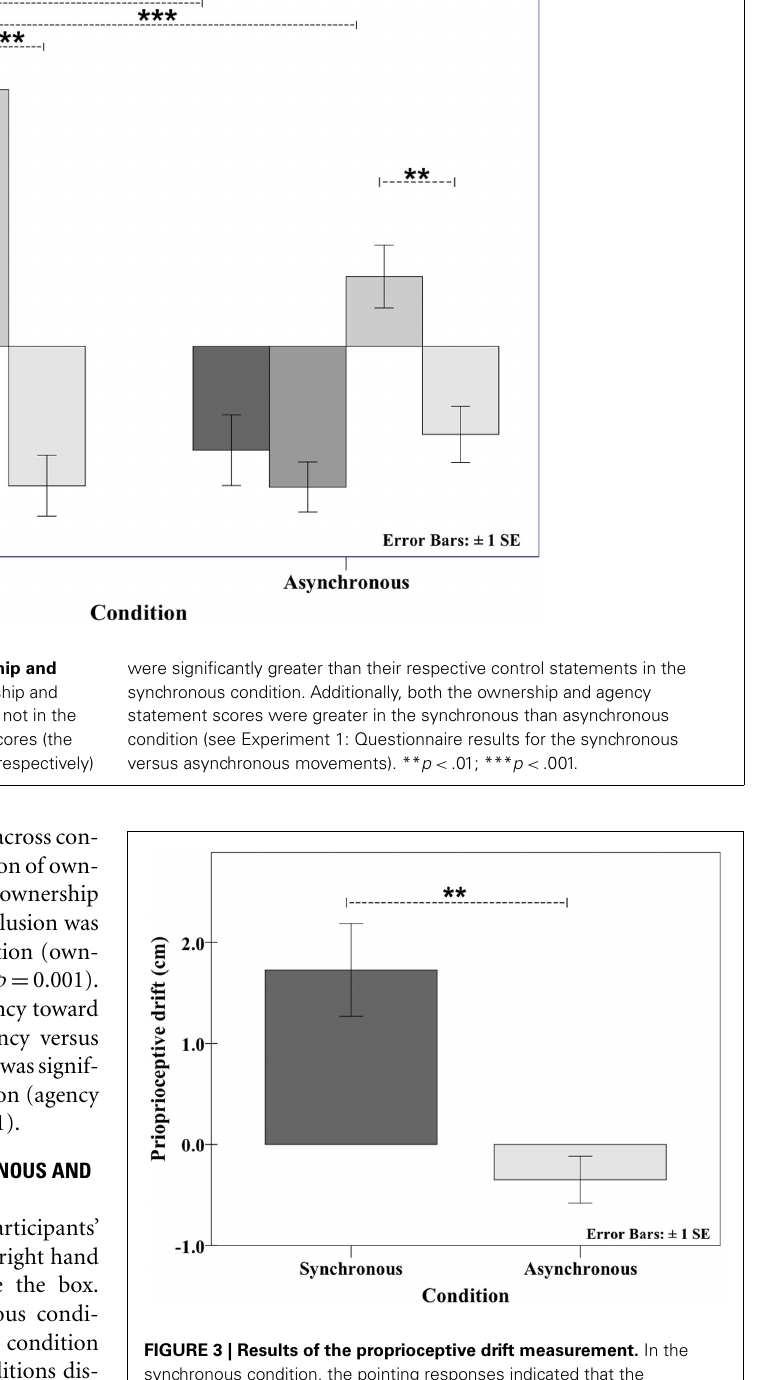
FIGURE 3 | Results of the proprioceptive drift measurement. In the synchronous condition, the pointing responses indicated that the participants estimated that their right hand was closer to the model hand (upward drift of 1.73cm).This effect was not observed in the asynchronous condition (see Experiment 2: Proprioceptive drift during synchronous and asynchronous active movements).